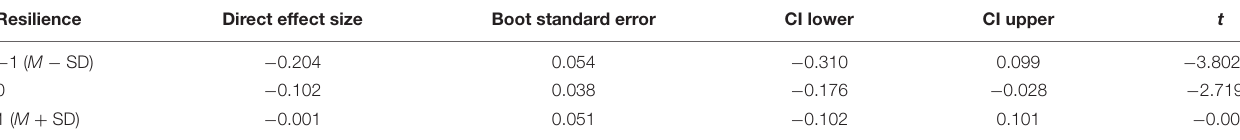
TABLE 5 | Direct effects of resilience’s different levels.